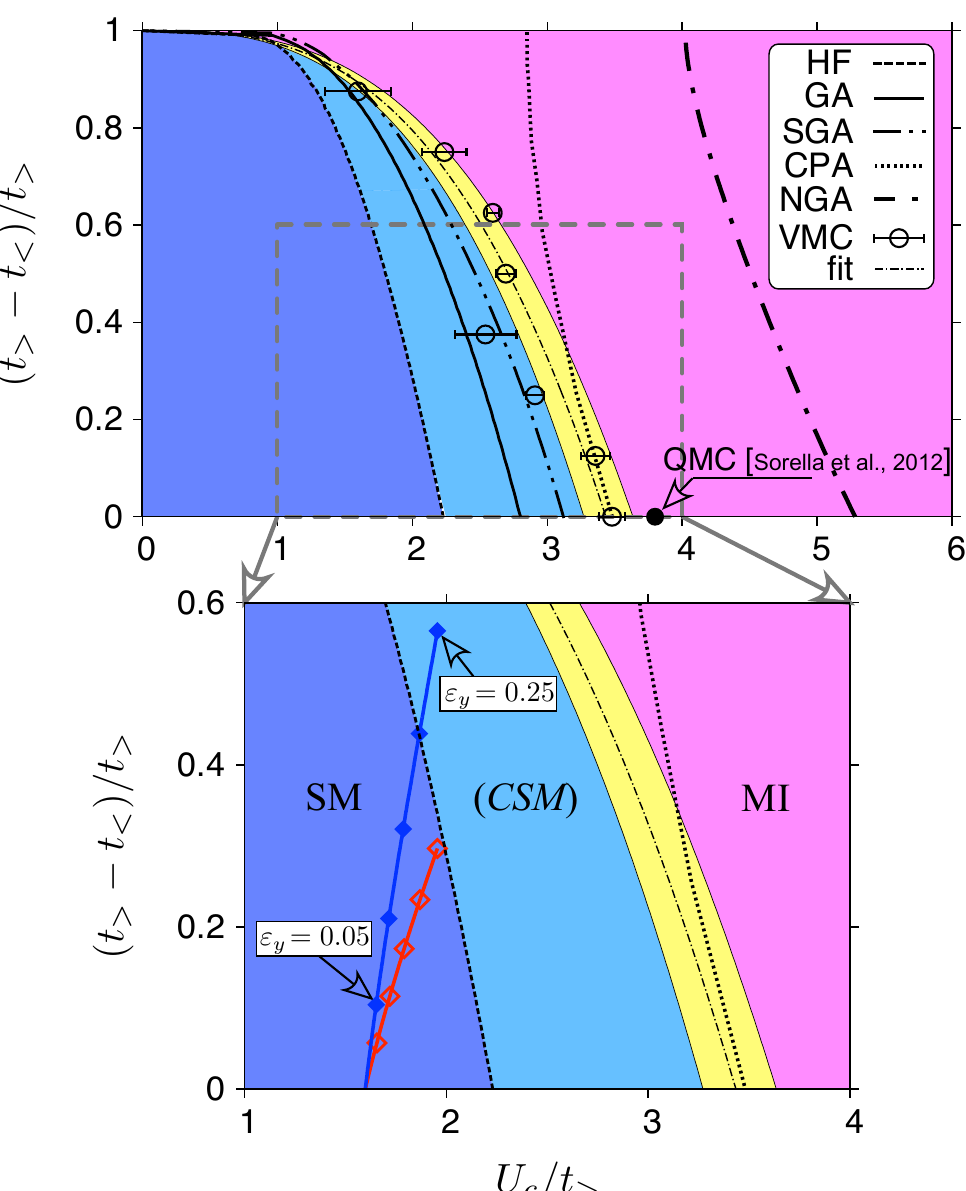
Figure 5. Top : Phase diagram for the Hubbard model on anisotropic honeycomb lattice, see Equations (1) and (2), with t y (cid:54) t x corresponding a gapless single-particle spectrum, see Figure 2. [Here, t > = t x and t < = t y .] Lines depict the critical Hubbard repulsion estimated within the Hartree–Fock method [short dashed], Gutzwiller Approximation [thick solid], Statistically Consistent GA [long dashed-double dotted], Coherent Potential Approximation [dotted], and the Néel-state GA [long dashed-dotted]. Datapoints with errorbars are obtained from VMC simulations for the Gutzwiller Wave Function, see Equation (12); thin dash-dotted line represents a power-law fit given by Equation (23) with thin solid lines bounding the statistical uncertainty (yellow area). Quantum Monte Carlo value for the isotropic case, U c / t 0 = 3.86 [18], is also marked (full circle). Bottom : A zoom in, with trajectories following from the SSH model for strained graphene (see Appendix B) for β = 2 (red line/open symbols) and β = 3 (blue line/closed symbols). Different datapoints for each value of β correspond to the applied strain ε y varied from ε y = 0.05 to 0.25 with the steps of 0.05. (GA and VMC results are omitted for clarity.) Remaining Labels/colored areas: the semimetallic phase (SM) [blue] with the correlated-semimetal range ( CSM ) [light blue] and the Mott insulator (MI)